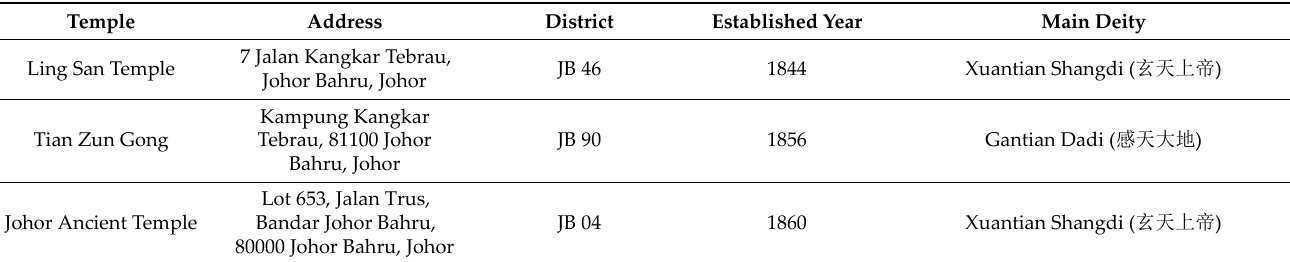
Table 5. The Earliest Temple Established in Johor Bahru.